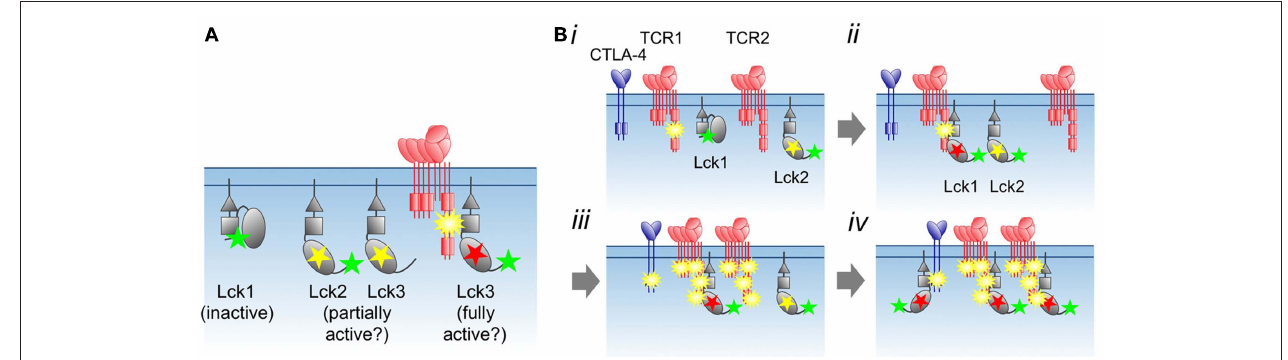
Figure 2 | Proposal for regulation of Lck by phosphorylation and substrate binding. (A) The distinct states of phosphorylated Lck, and their proposed levels of activity. Yellow and green stars correspond to phosphorylated Tyr 394 and Tyr 505 , respectively, whereas the red star marks Lck allosterically and/or stably activated by substrate binding. (B) Local, switch-like activation of Lck. (i) Immediately following incipient receptor triggering, the TCR is weakly phosphorylated. Via random collisions with other kinases or phosphatases in the membrane (see Figure 1 ), Lck transits between inactive (Lck1) and partially active (Lck2) states. (ii) The phosphorylated receptor competes with phosphorylated Lck1 Tyr 505 for binding to the SH2 domain of Lck1, which activates the kinase allosterically